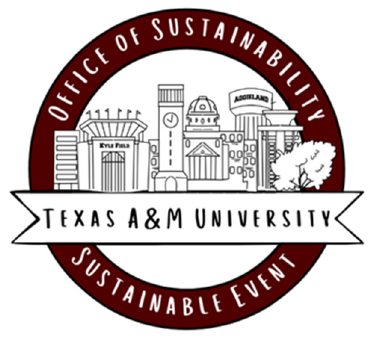
Figure 4. Current SEC icon.